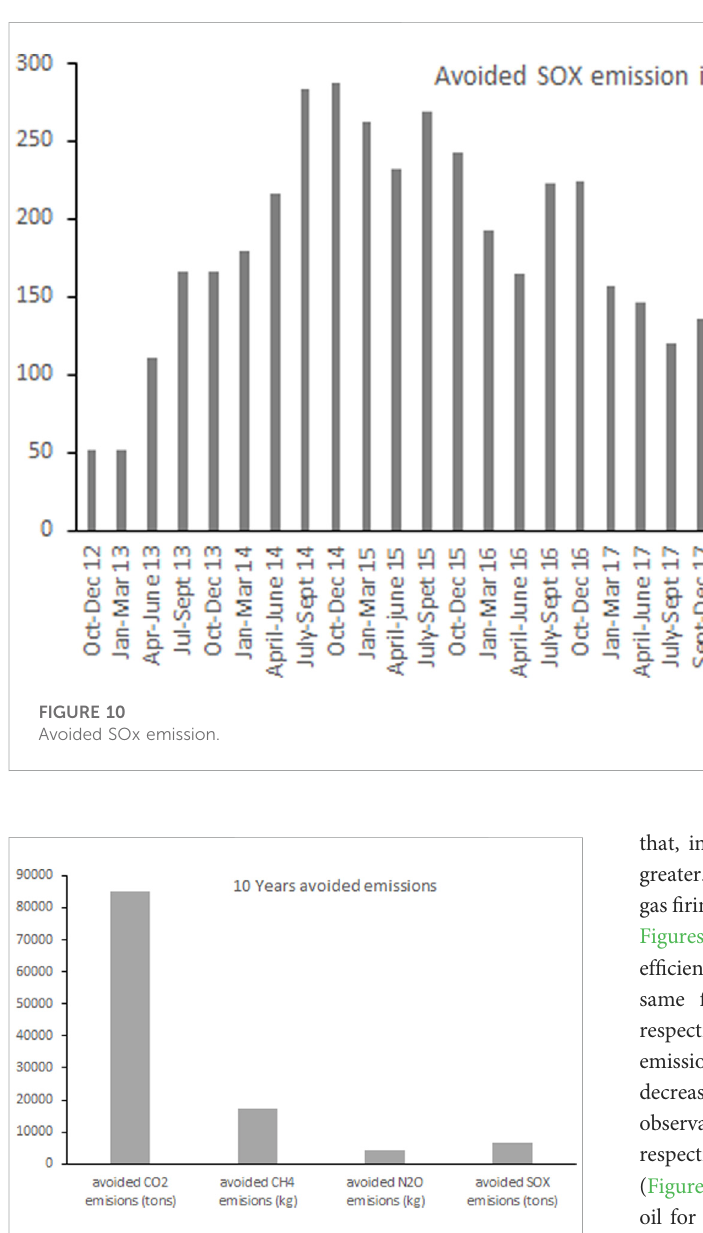
FIGURE 11 Ten years ’ avoided